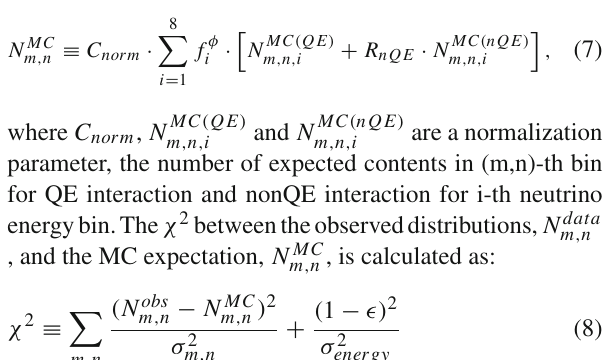
Fig. 22 The particle identification likelihood. The events less than or equal to 0.0 are considered to be e-like while those greater than 0.0 are μ -like. Data are the circles and MC is the histogram. The Shaded histogram is for CC QE events in MC